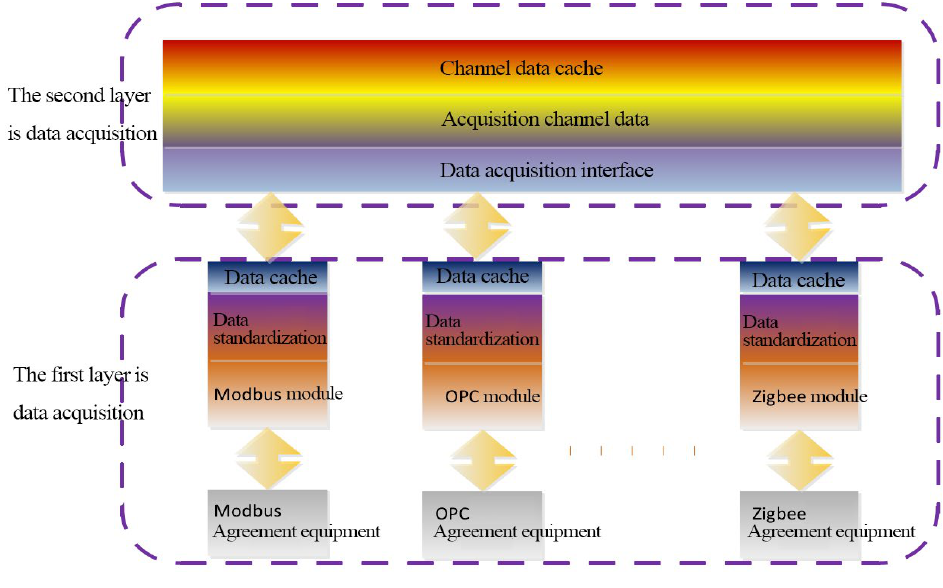
Figure 5. Principles of data collection.